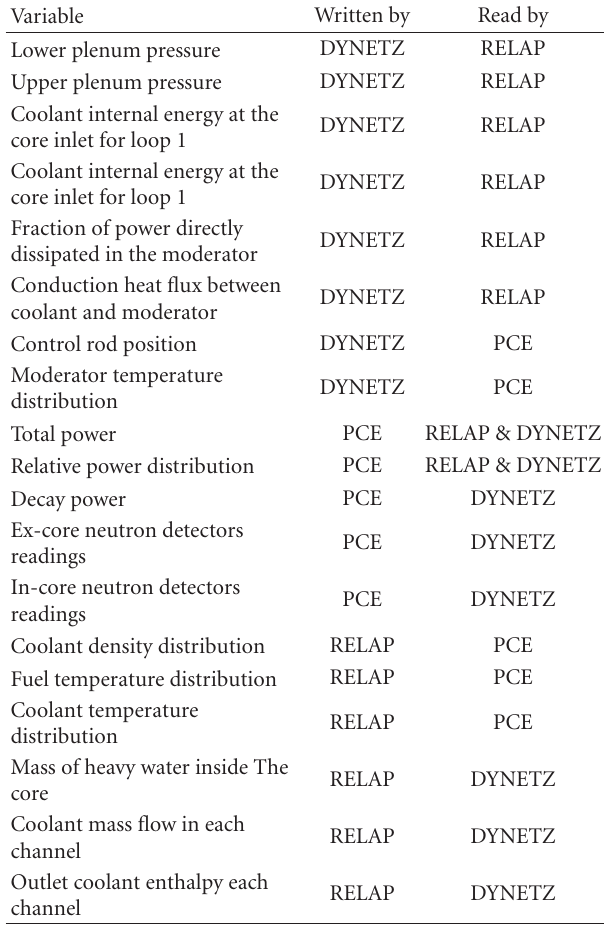
Table 2: Information exchanged by the three codes. The actual values are stored in shared memory segments and are read by each code after the corresponding semaphore is set to green by the main code